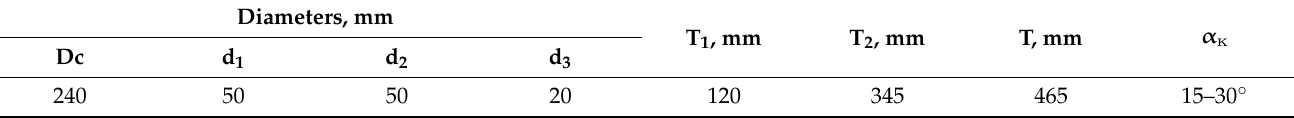
Table 1. Structural dimensions of the